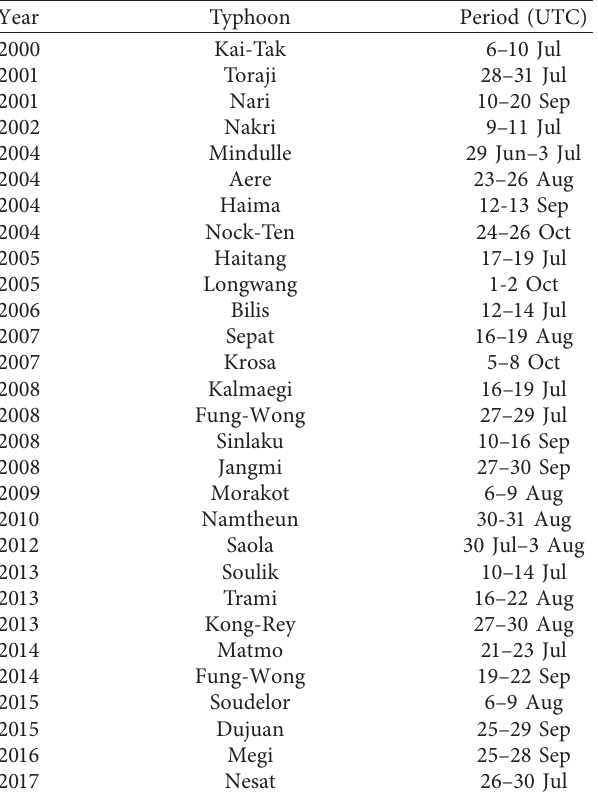
Figure 3: Map of Taiwan’s northeastern region and the meteorological stations therein. Table 1: Typhoons affecting the study area from 2000 to 2017 (29 incidents).